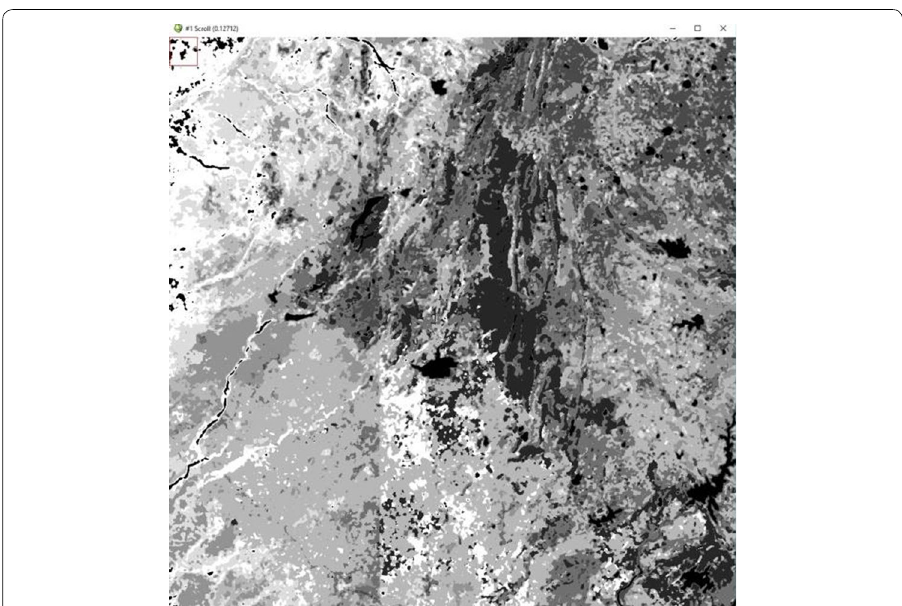
Fig. 6 8k image file after being clustered and plotted (cluster visualization from